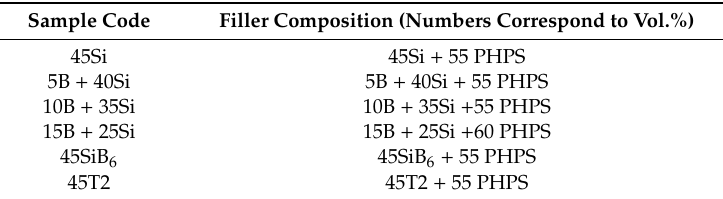
Table 2. List of compositions and sample